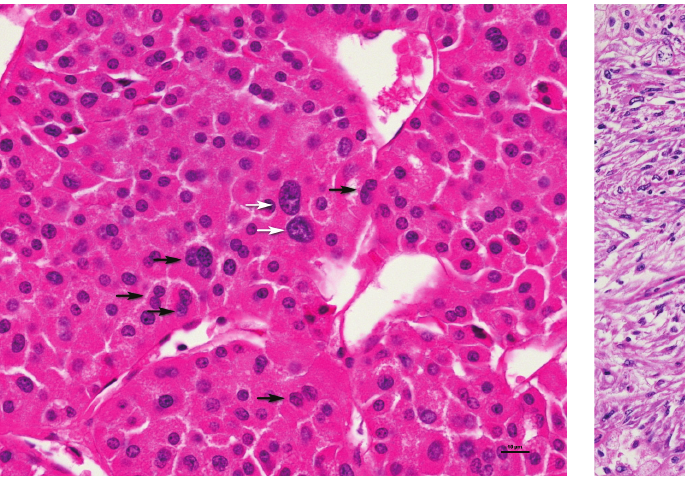
Figure 3: Tumor cells with sarcomatoid change (black arrow) (200x), CTG 3, FNG